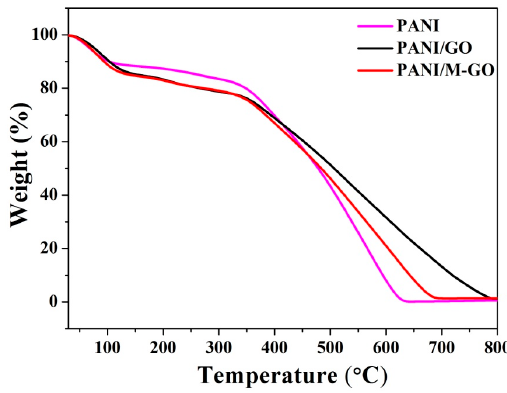
Figure 10. Thermogravimetric (TG) curves of PANI, PANI/GO, and PANI/M-GO composites.